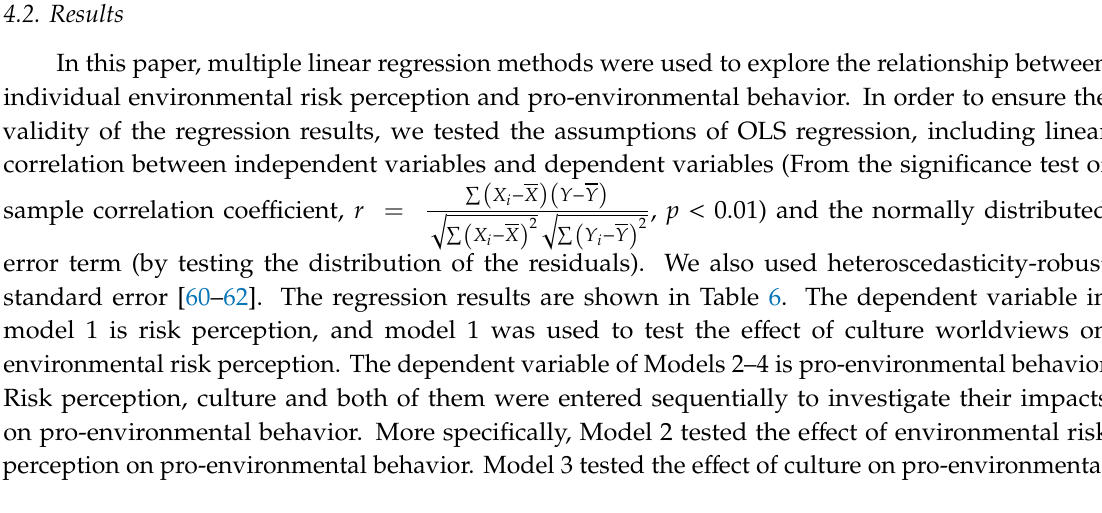
Figure 5. Risk perception and Pro-environmental Behavior.